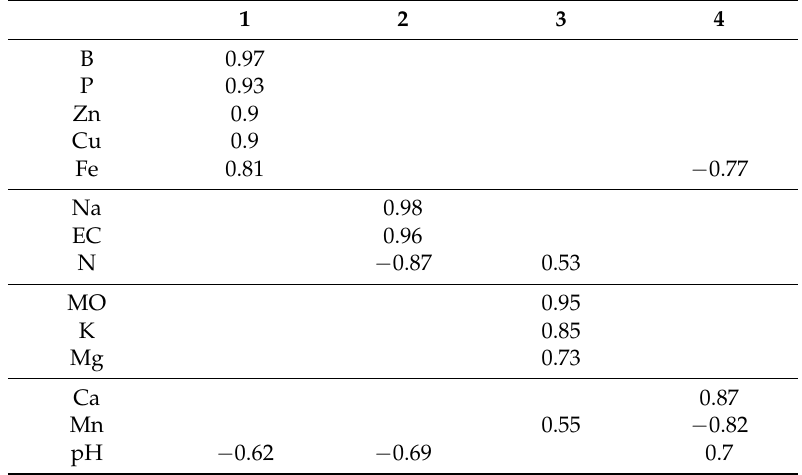
Table 4. Structure of principal